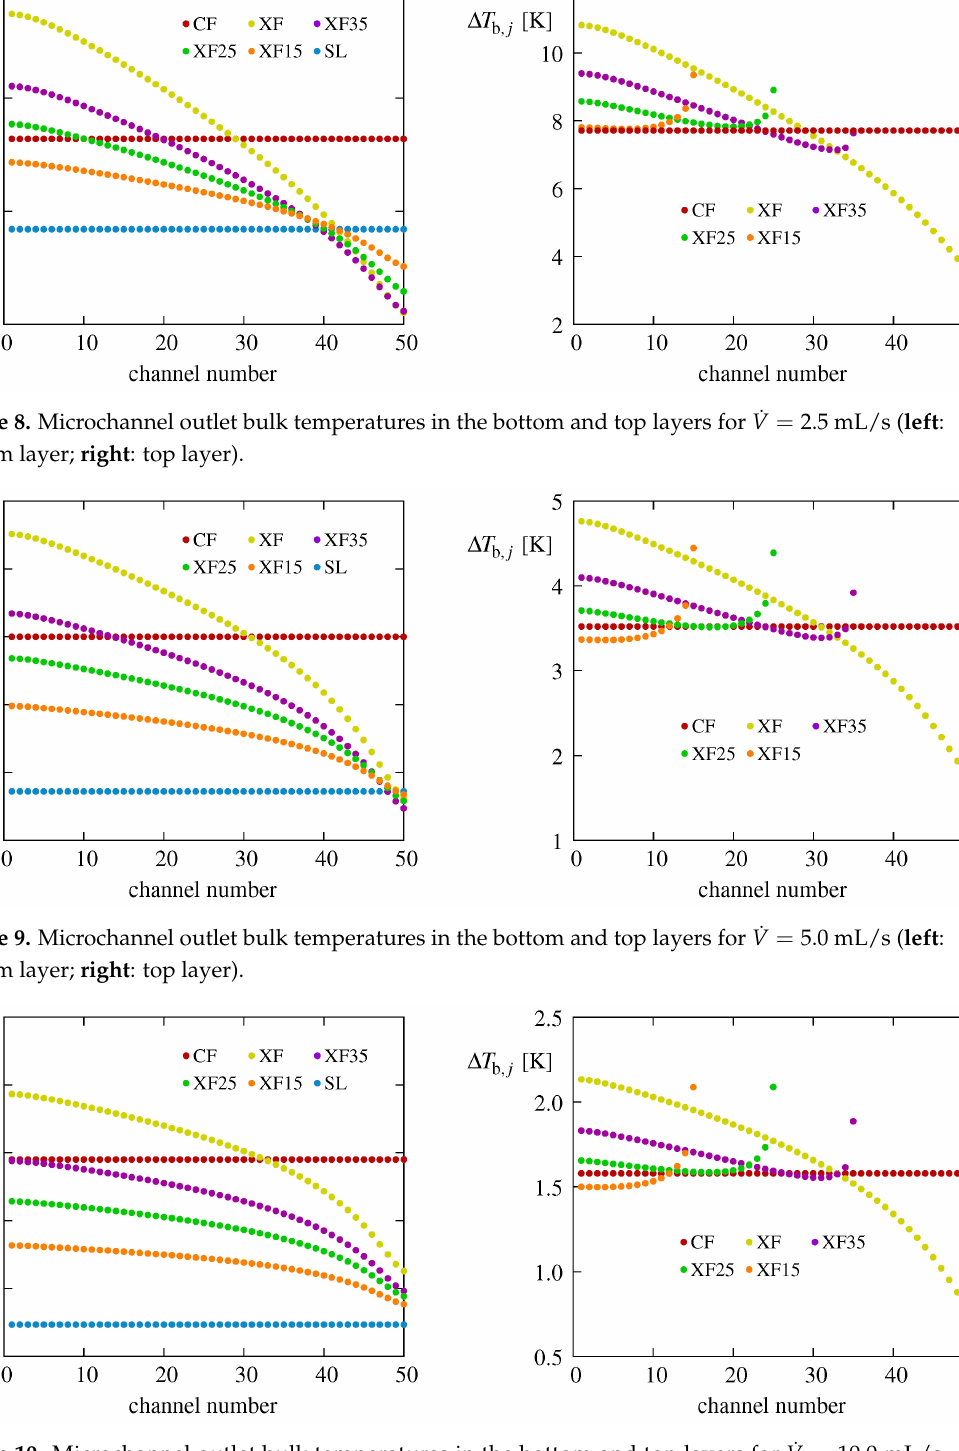
Figure 10. Microchannel outlet bulk temperatures in the bottom and top layers for ˙ V = 10.0 mL/s ( left : bottom layer; right : top